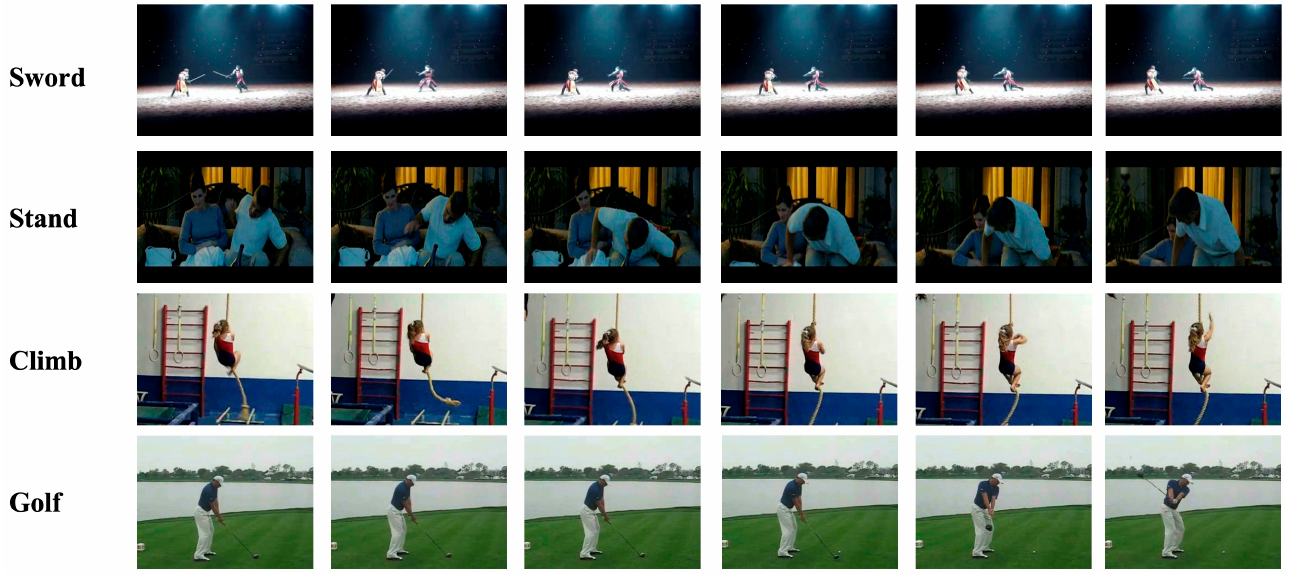
Figure 8. Frame examples of the HMDB51 dataset.